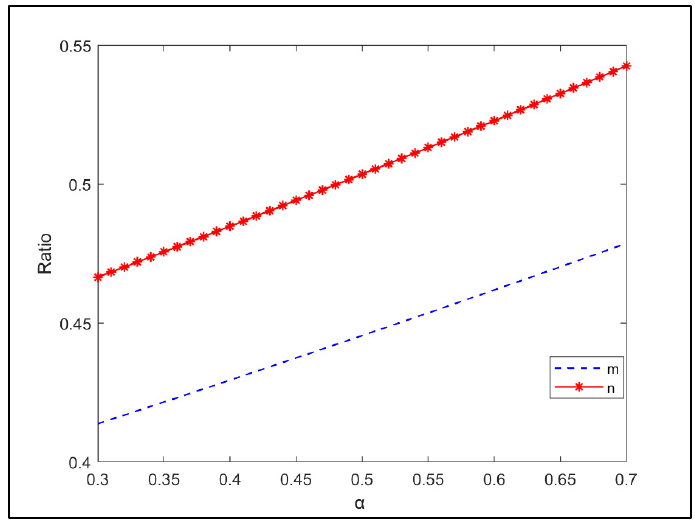
Figure 7. The effects on the optimal cost-sharing ratios.